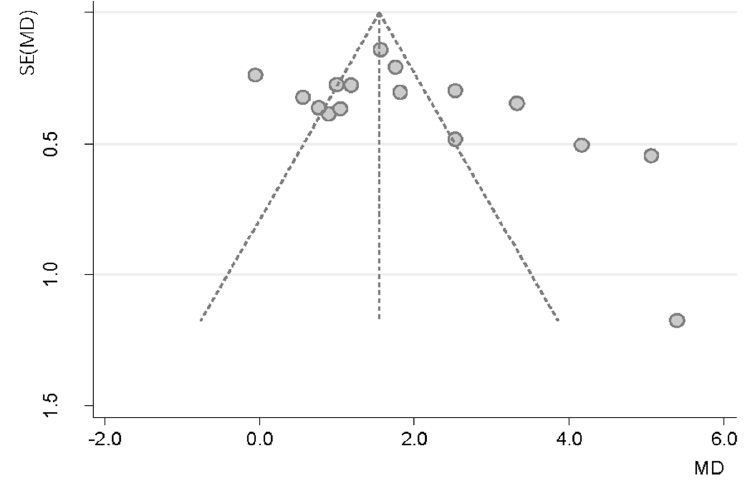
Figure 4. Funnel plot of serum vitamin D changes in patients with type 2 diabetes receiving vitamin D supplementation based treatment versus controls in 16 randomized controlled trials (Each circle represents a study, with the y-axis representing the standard error of the study and the x-axis meaning the weighted mean difference of it. The funnel-shaped distribution is created by studies with high precision plotted near the average, and studies with low precision spread evenly on both sides of the average. Deviation from this shape indicates publication bias).